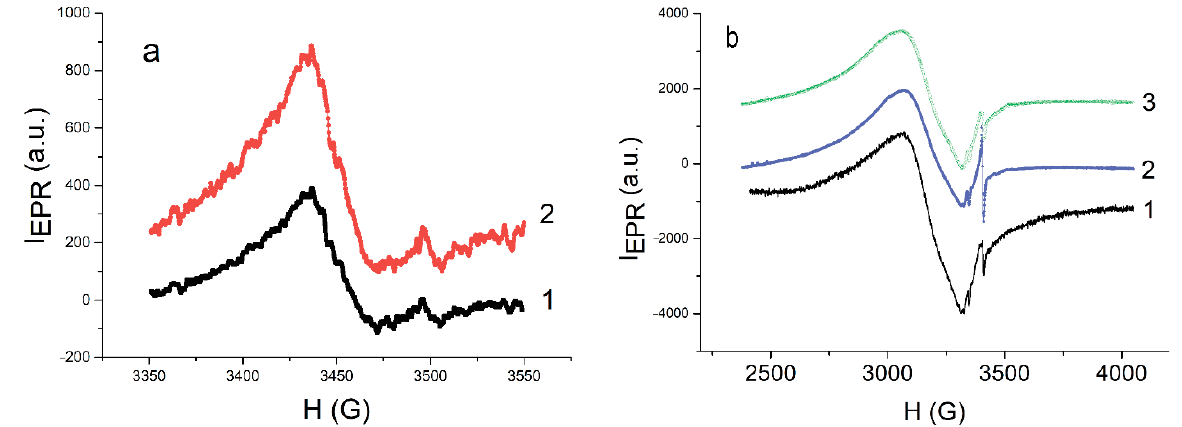
Figure 5. ( a ) EPR spectra of SW TiO 2 NTs in dark (1) and under illumination (2). ( b ) EPR spectra of SW TiO 2 NTs/Cu x O-30 in dark (1), under illumination (2) and in dark after illumination (3).